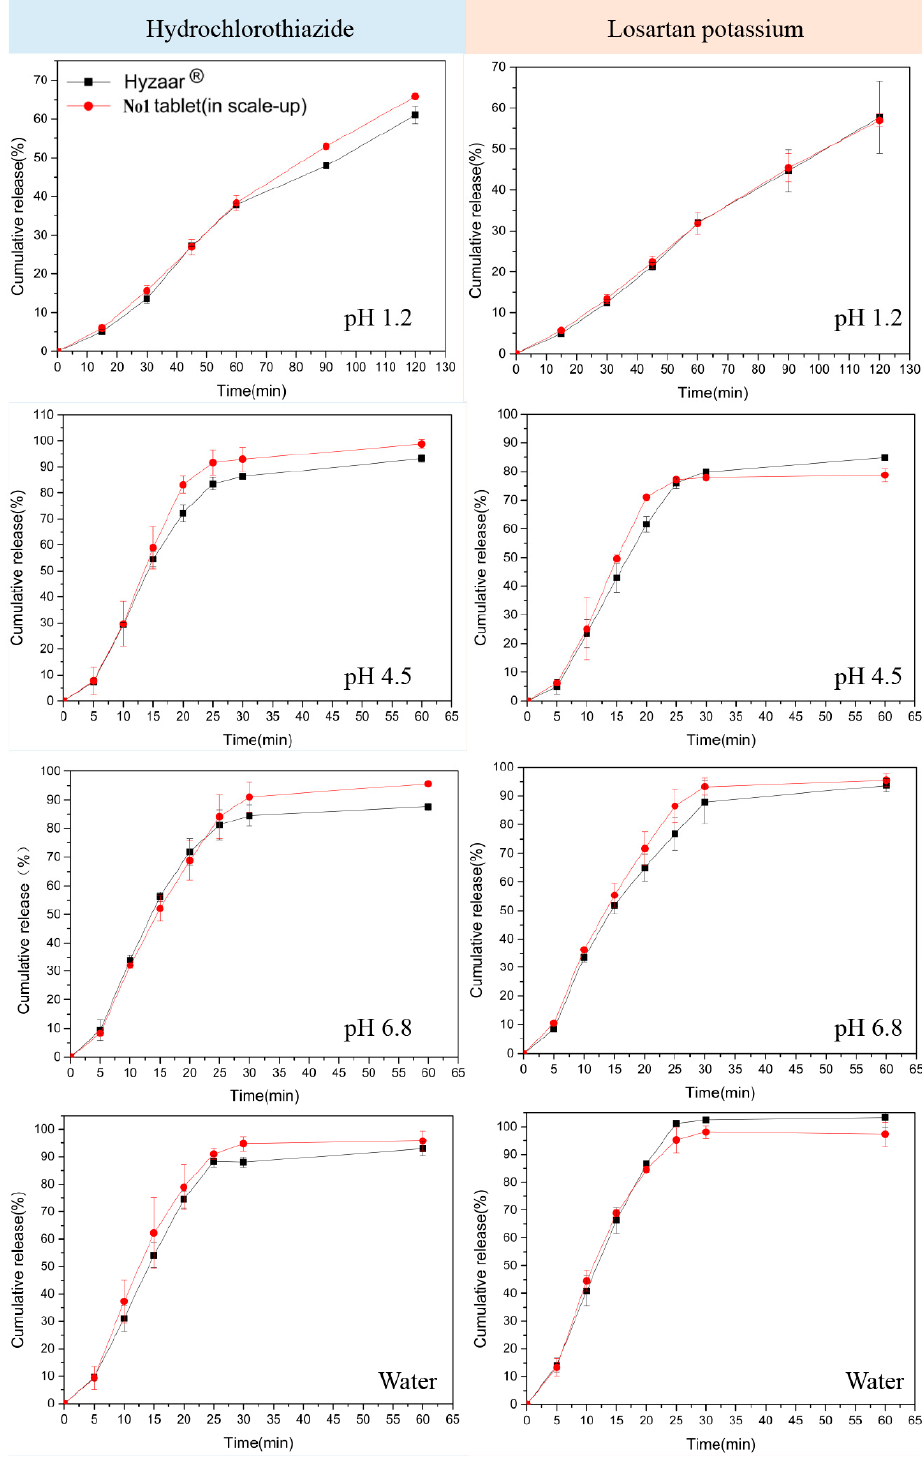
Figure 9. HCTZ/LOS-K dissolution rate in different medium solution.